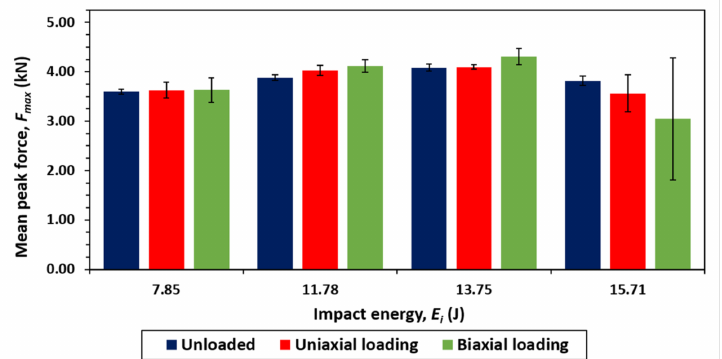
Figure 15. Mean peak force, F max , against impact energy, E i , shown for three different loading conditions: unloaded, uniaxial loading and biaxial loading.